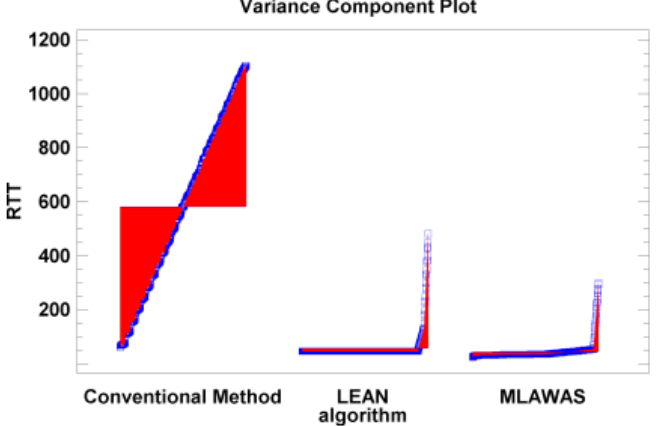
Figure 8. Round-Trip Time (RTT) of Workload During Offloading. There is a migration delay between E-Transport and cloudlet, and cloudlet and cloud computing during the offloading and execution processes of the workload. This controls the load balancing situation. When the cloudlet becomes overloaded, it will migrate some workload to the cloud for further execution. However, LEAN and conventional methods did not consider the migration delay in their studies. Figure 9 shows that MLAWAS gained a shorter migration delay as compared to existing baseline methods during the migration of the workload from cloudlet to cloud for further